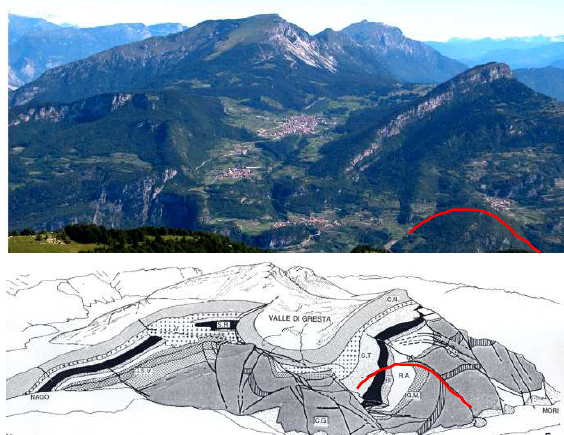
Figure 13. Aerial view (top) and scheme of the geological conformation (bottom) of the Gresta Valley. [Courtesy of M. Avanzini]